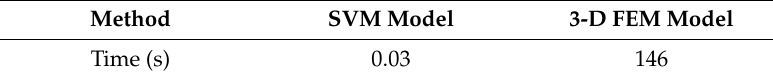
Table 3. Solving times of single